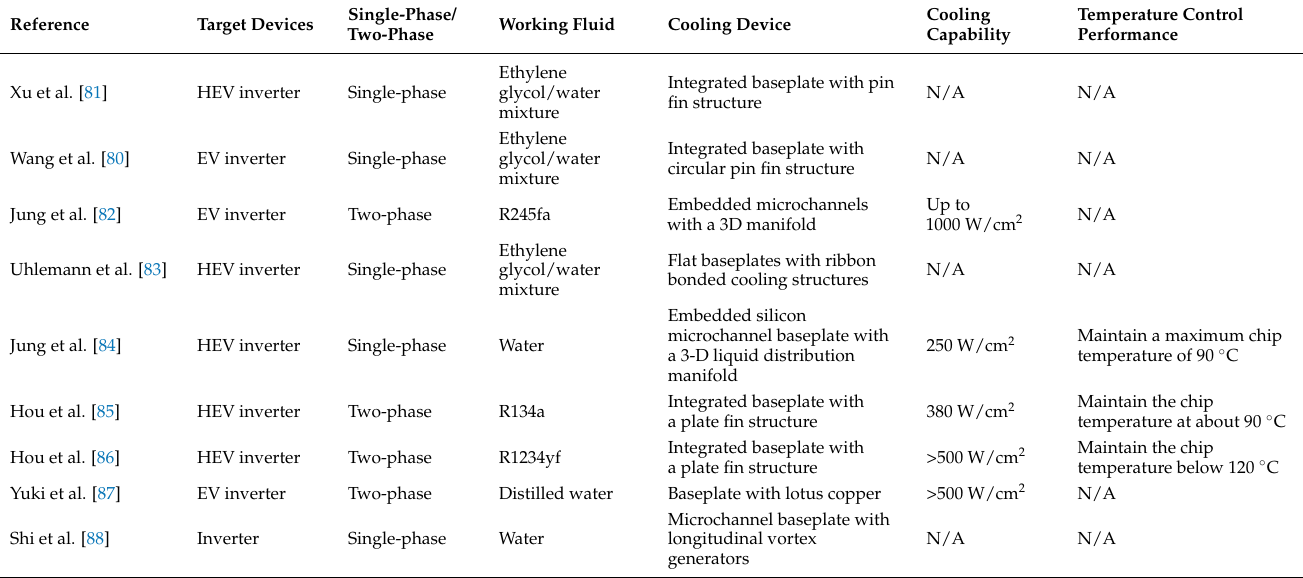
Table 6. Summary of studies focusing on the direct contact baseplate